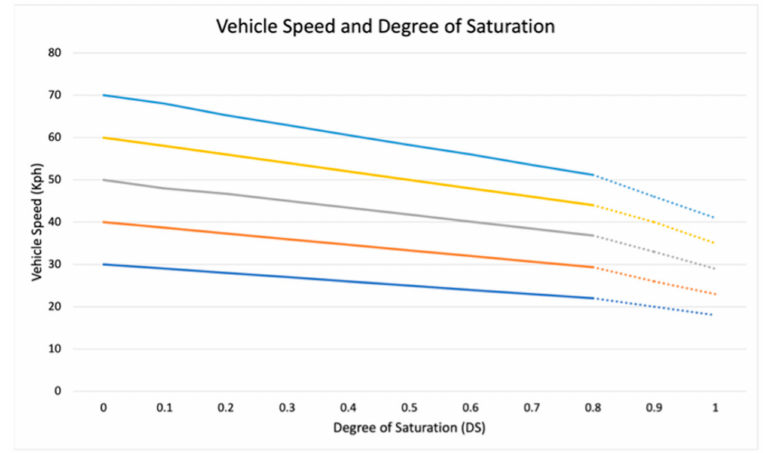
Figure 1. The rule of vehicle speed and saturation degree.